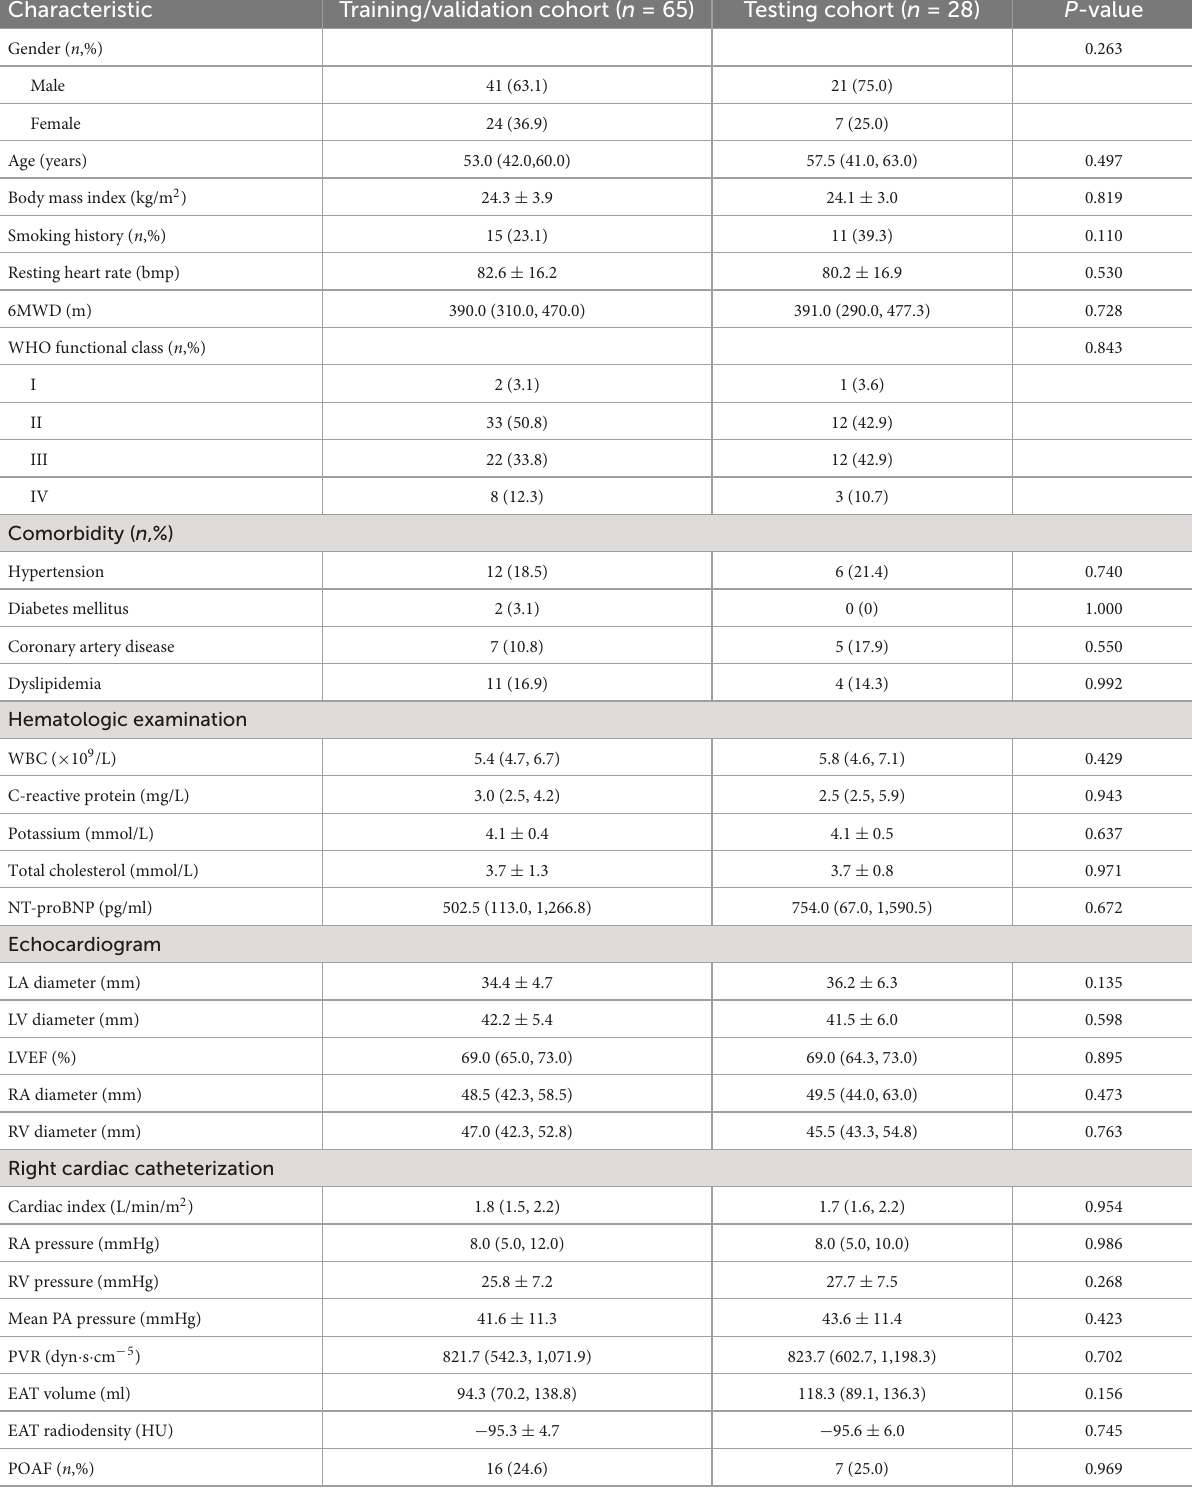
TABLE 1 Clinical characteristics in training/validation and testing cohorts.